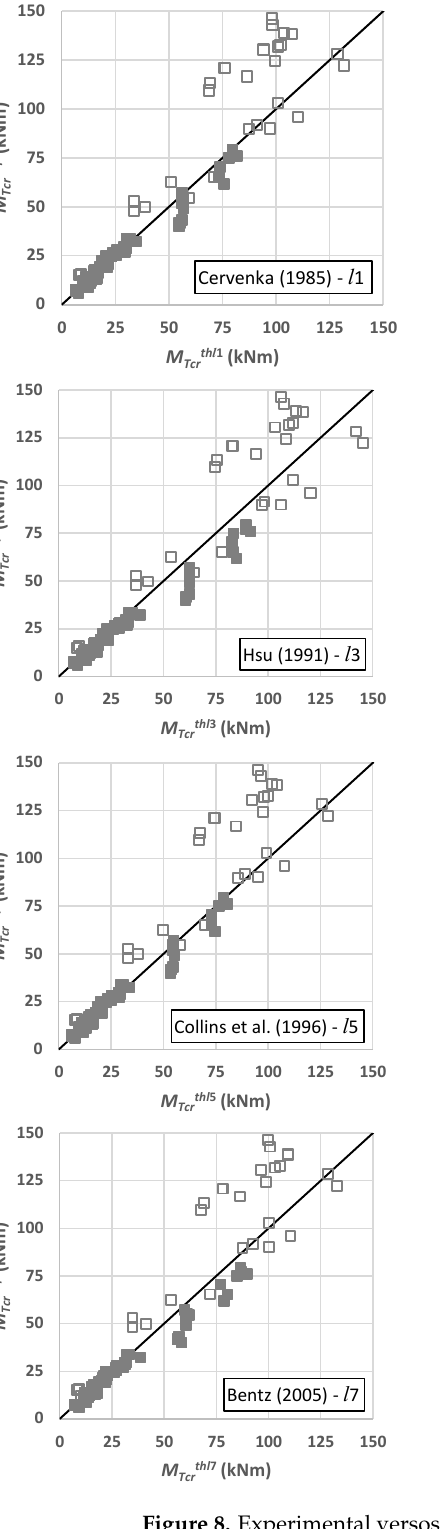
” for RC hollow beams.